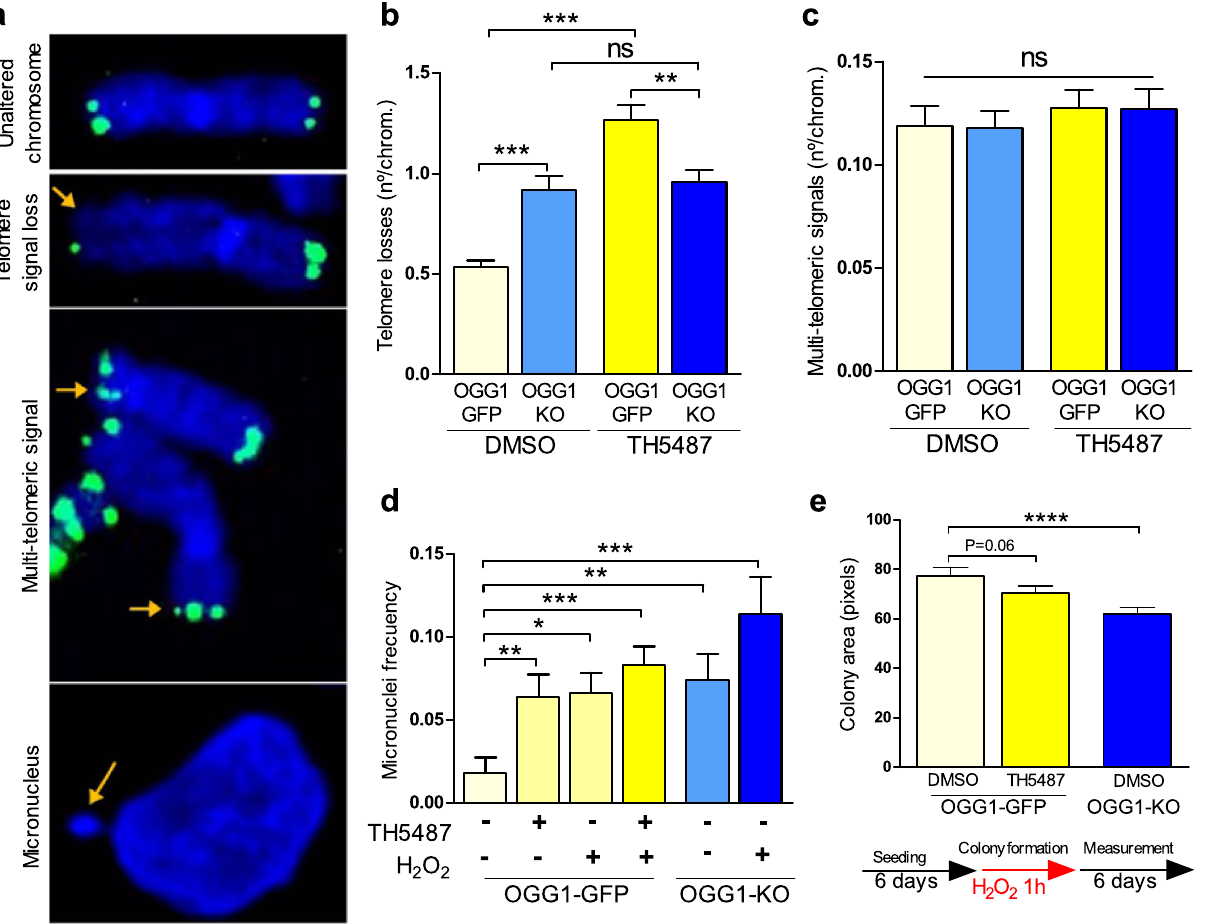
Figure 3. Pharmacological OGG1 inhibition results in telomere losses and post-mitotic defects. ( A ) Representative Telo-FISH images of an unaltered chromosome in metaphase stained with DAPI (in blue) with the corresponding telomeric signals (in green) at the end of each chromatid. Below, Representative Telo- FISH images of altered chromosomes showing telomere signal loss in one of the chromatids, multi-telomeric signals, and a micronucleus (orange arrows). ( B ) Quantification of telomeric signal-free ends for the indicated conditions in U2OS OGG1-GFP or OGG1-KO cells. Bars show the mean and the SEM for frequency events/ metaphase (30 to 35 metaphases per condition from 2 independent experiments). Statistical significance was determined using unpaired, two-sided T-tests (**P < 0.01, ***P < 0.001 and ns: not significant). ( C ) Comparative analysis of the frequency of multi-telomeric signals for the indicated conditions in U2OS OGG1-GFP or OGG1-KO cells. Bars show the mean and the SEM for frequency events/metaphase (30 to 35 metaphases per condition from 2 independent experiments). Statistical significance was determined using unpaired, two-sided T-tests (P > 0.05, ns: not significant). ( D ) Comparative analysis of micronuclei formation frequency for U2OS OGG1-GFP incubated with DMSO or TH5487 and for OGG1-KO at basal conditions or during OS. More than 200 cells per condition were analyzed. Data is the average of 2 independent experiments. Significant differences were calculated using the Mann–Whitney test for non-parametric distributions (**P < 0.01, ***P < 0.001, **** P < 0.0001). ( E ) Up, comparative analysis for the colony area generated in each condition. Significant differences were calculated using the Mann–Whitney test for non-parametric distributions (**** P < 0.0001). Down, summary for the schedule of treatment to evaluate a specific clonogenic potential feature (area of colonies). Data are average of the mean colony area values of a single